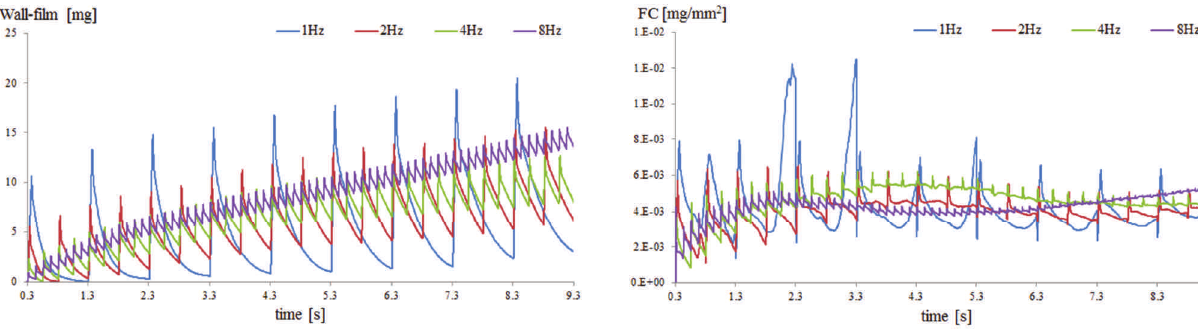
Fig. 7. Total wall film mass for medium load